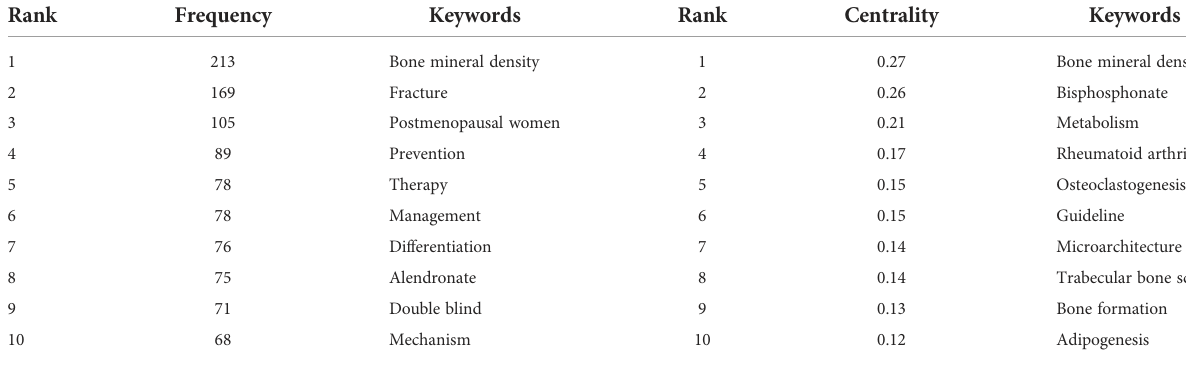
TABLE 7 The top 10 keywords in terms of frequency and centrality.